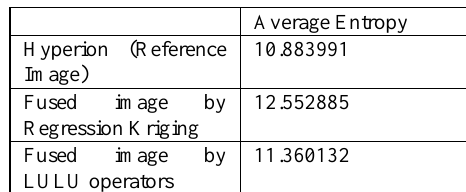
Figure 3: Fused Image of Regression Kriging LULU operators